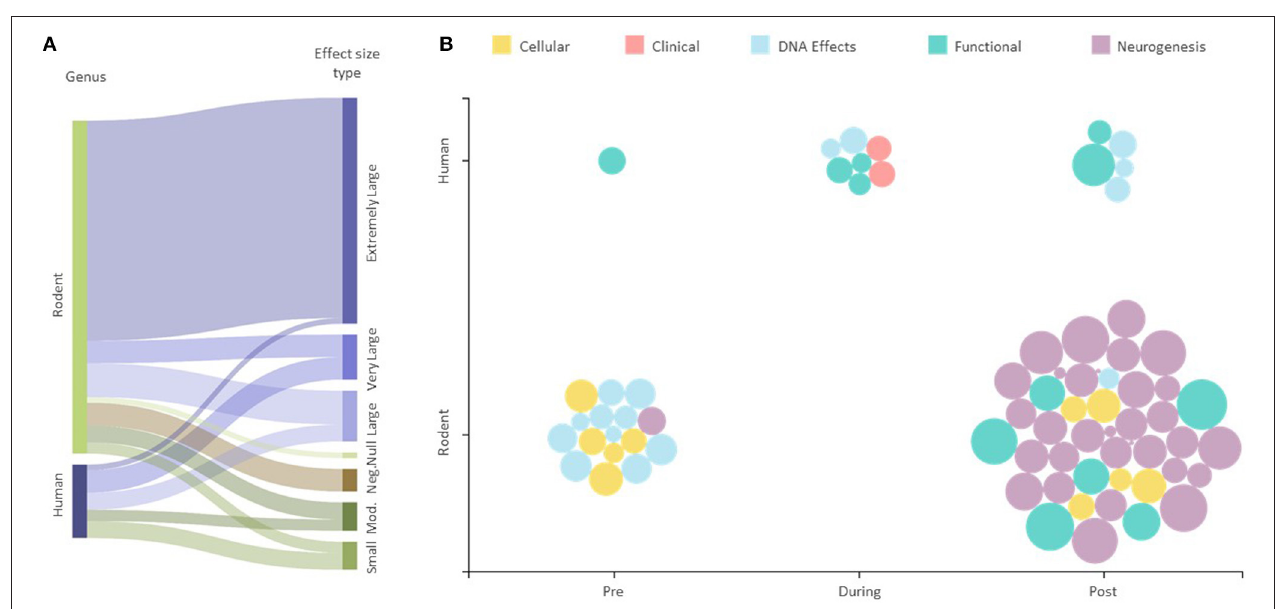
FIGURE 2 | Effect of exercise intervention explained by experimental conditions. (A) Sankey diagram showing the effect sizes for all human and animal studies. The string thicknesses refer to the total number of outcomes for each category. “Mod.” —Moderate, “Neg.”—Negative, “Null “—No effect. (B) Effect size scatter plot showing all human and animal outcomes. Pre, During, and Post refer to the time at which the exercise intervention was applied with respect to the radiation exposure. The size of bubbles represents the effect sizes for each outcome